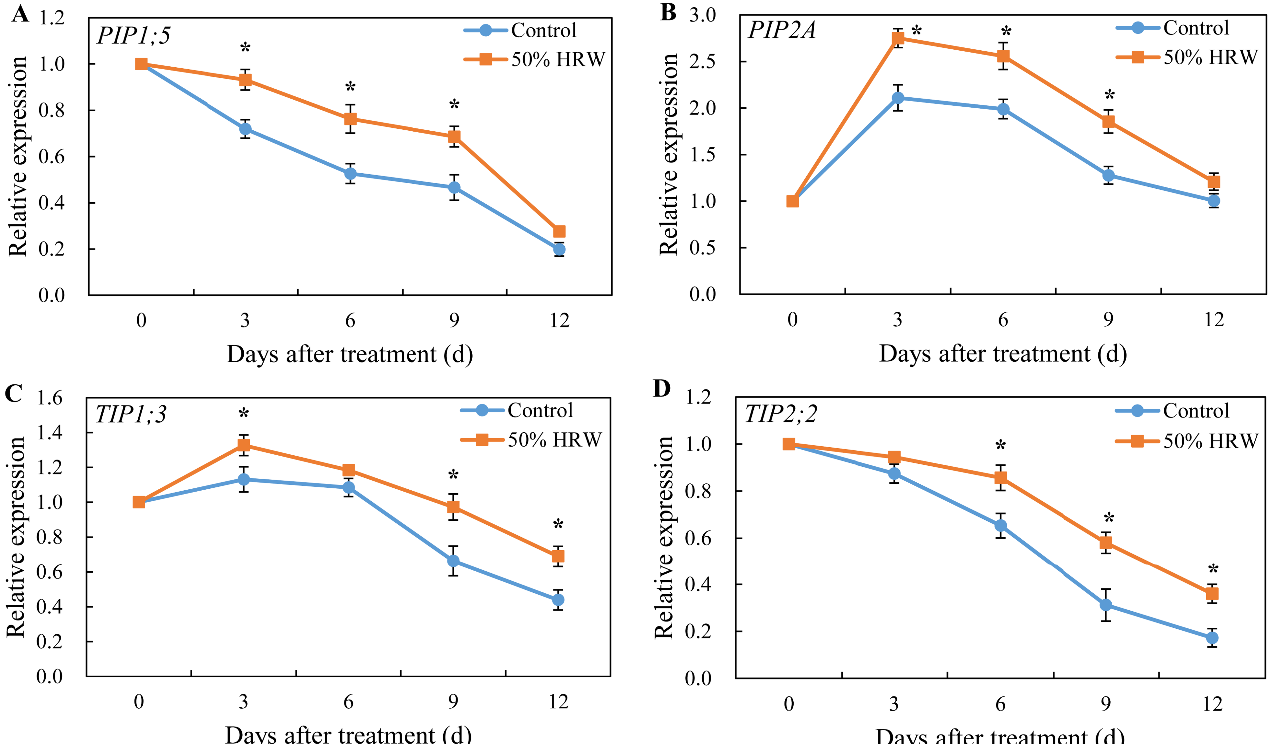
Figure 4. Expression of PIP1;5 ( A ), PIP2A ( B ), TIP1;3 ( C ), and TIP2;2 ( D ) genes in Lanzhou lily scales with or without 50% HRW treatment during storage at room temperature for 12 days. Values are the mean ± SE of three independent experiments. The asterisks denote t -test significance between the control and 50% HRW treatment on the same day: * p < 0.05. HRW: hydrogen-rich water. PIP1;5 : Aquaporin G Carbohydrate transport and metabolism, PIP2A : Aquaporin G Carbohydrate transport and metabolism, TIP1;3 : Aquaporin G Carbohydrate transport and metabolism, TIP2;2 : Aquaporin G Carbohydrate transport and metabolism.